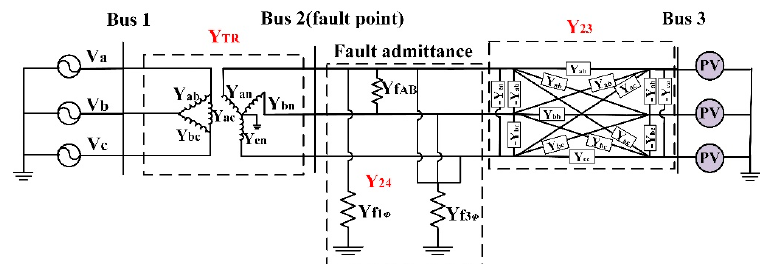
Figure 6. Three-phase admittance configuration of a distribution network under a fault.